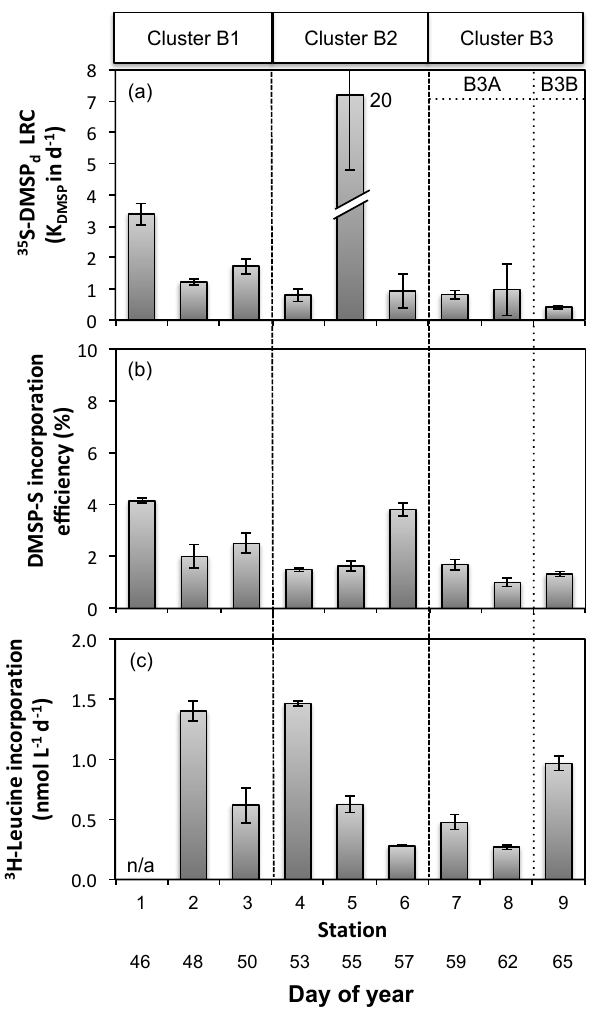
Figure 3. (a) Microbial DMSP d loss rate constant ( k DMSP in day − 1 ); (b) microbial assimilation efficiency of DMSP-S into macromolecules (%); (c) microbial 3 H-leucine incorporation (nmolL − 1 day − 1 ) at nine stations during the SOAP voyage in February and March 2012. The three sampling clusters are noted as B1, B2, and B3. Stacks and error bars indicate mean and stan- dard deviation of triplicate samples. NA indicates data that are not available.